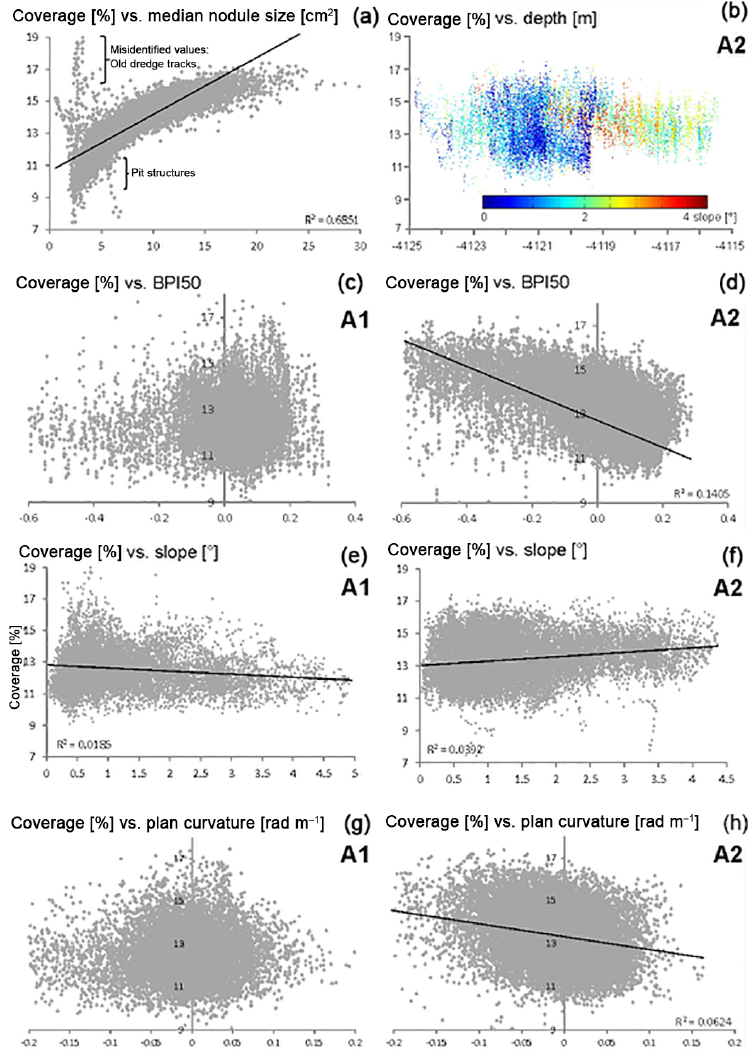
Figure 6. Scatterplots indicating relationships between Mn-nodule percent coverage (%) and eight other nodule and terrain values: median nodule size in cm 2 (a) , depth within the A2 sub-area ( b , color-coded by slope), BPI50 (c, d) , slope (e, f) and plan curvature (g, h) . Charts (c, e, g) relate to sub-area A1; charts (b, d, f, h) to sub-area A2. The sub-areas show different correlations.